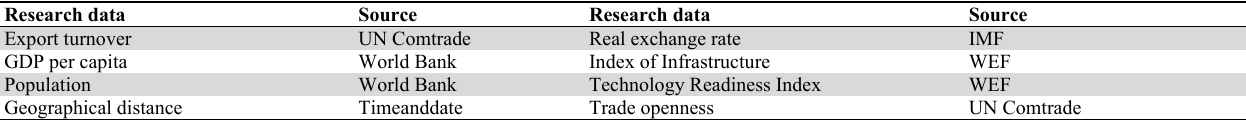
The source of data